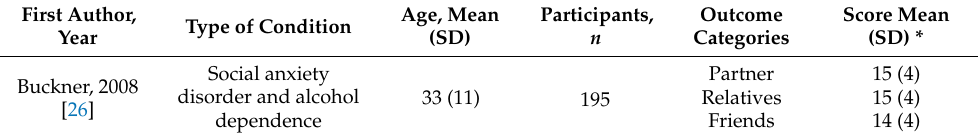
Table 6. Relationship stress.